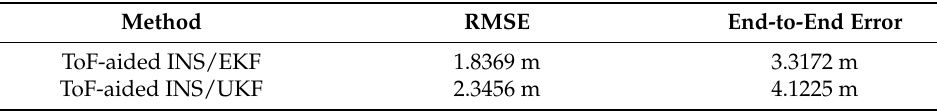
Table 5. The RMSE and the end-to-end 2D position error for scenario